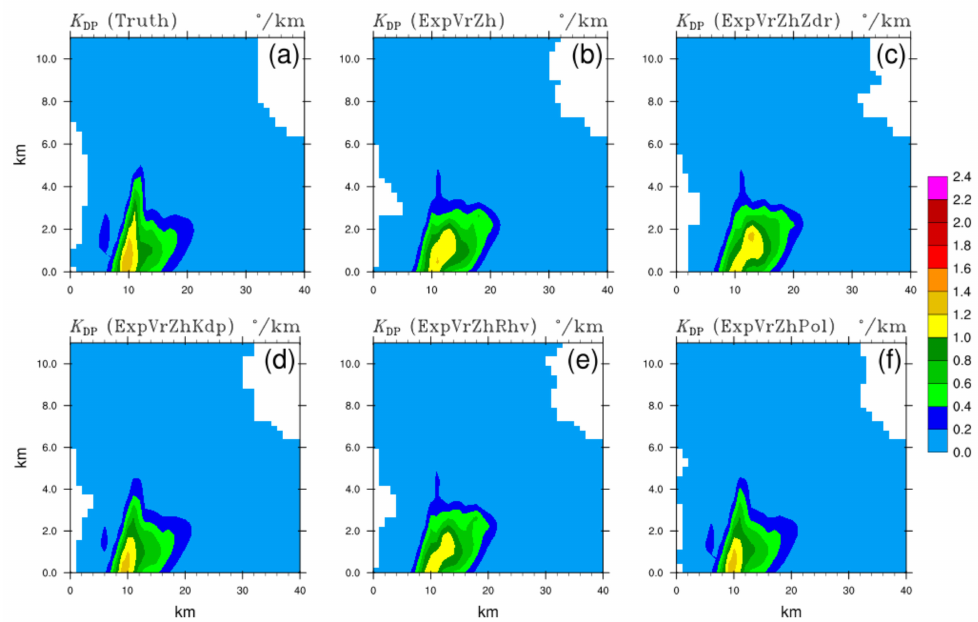
Figure 9. The same as Figure 7, but for the specific differential phase K DP of ( a ) truth, and analysis fields of ( b ) ExpVrZh, ( c ) ExpVrZhZdr, ( d ) ExpVrZhKdp, ( e ) ExpVrZhRhv, and ( f ) ExpVrZhPol, respectively.